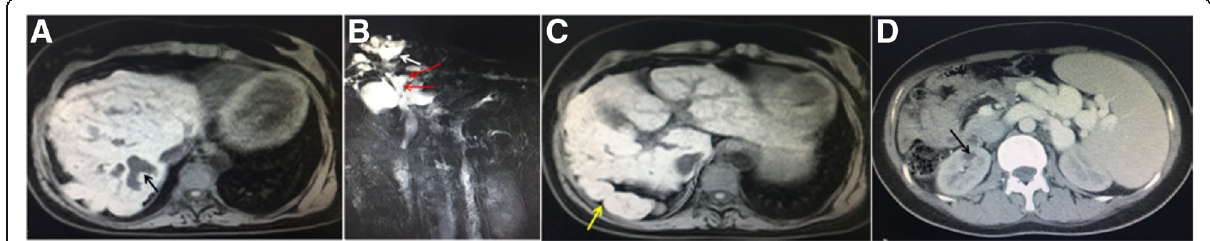
Fig. 2 The patient ’ s radiological imaging findings are consistent with Caroli ’ s syndrome. a Cross-sectional MRI images show intrahepatic bile duct